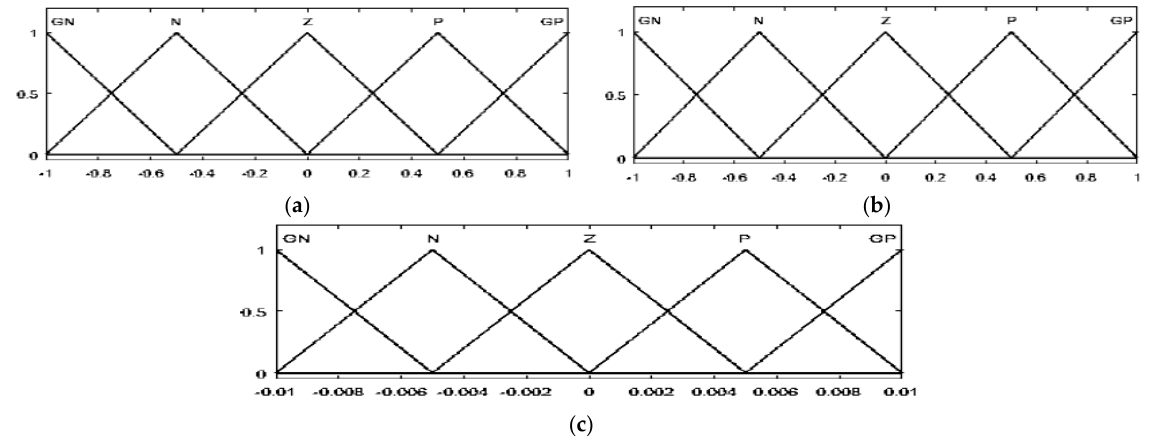
Table 3. Fuzzy controller inference rules.